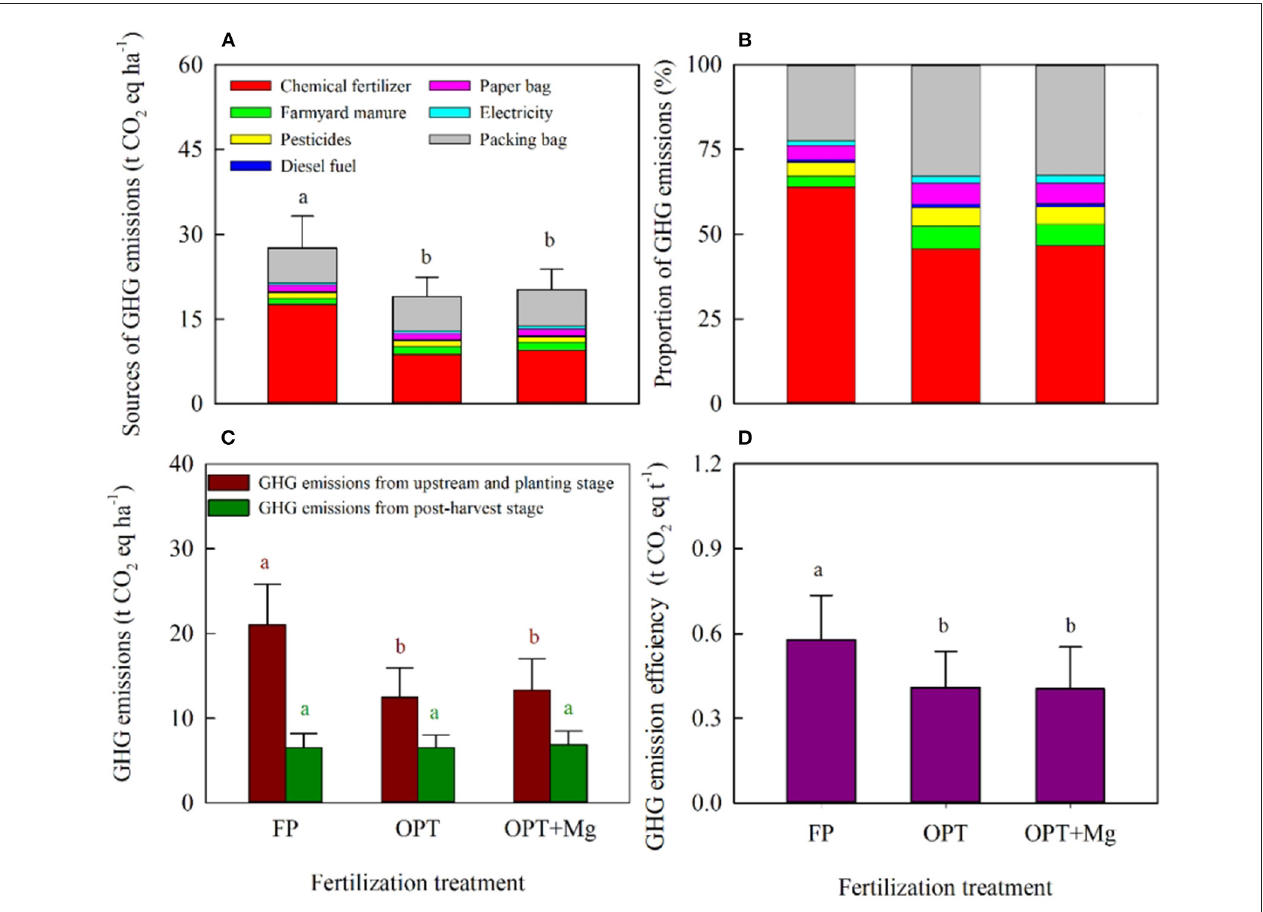
FIGURE 5 | Different sources (A) and proportions (B) of greenhouse gas (GHG) emissions, GHG emissions from different stages (C) , and GHG emissions efficiency (D) under different fertilization treatments in pomelo production. The black error bars in the figure indicate the standard deviations (SDs). Different letters above histogram bars with the same pattern indicate statistically significant differences at P <